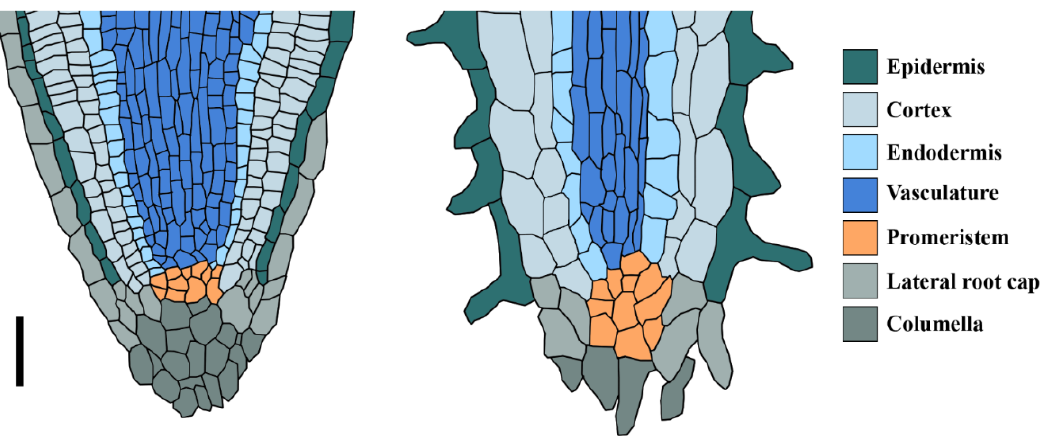
Figure 2. Determinate root growth correlates with cactus meristem differentiation; left: undifferentiated cactus root meristem; right: differentiated meristem with root hairs at the root tip. Root schemes were adapted from real tissue sections described in [33]; scale bar 50 μm.